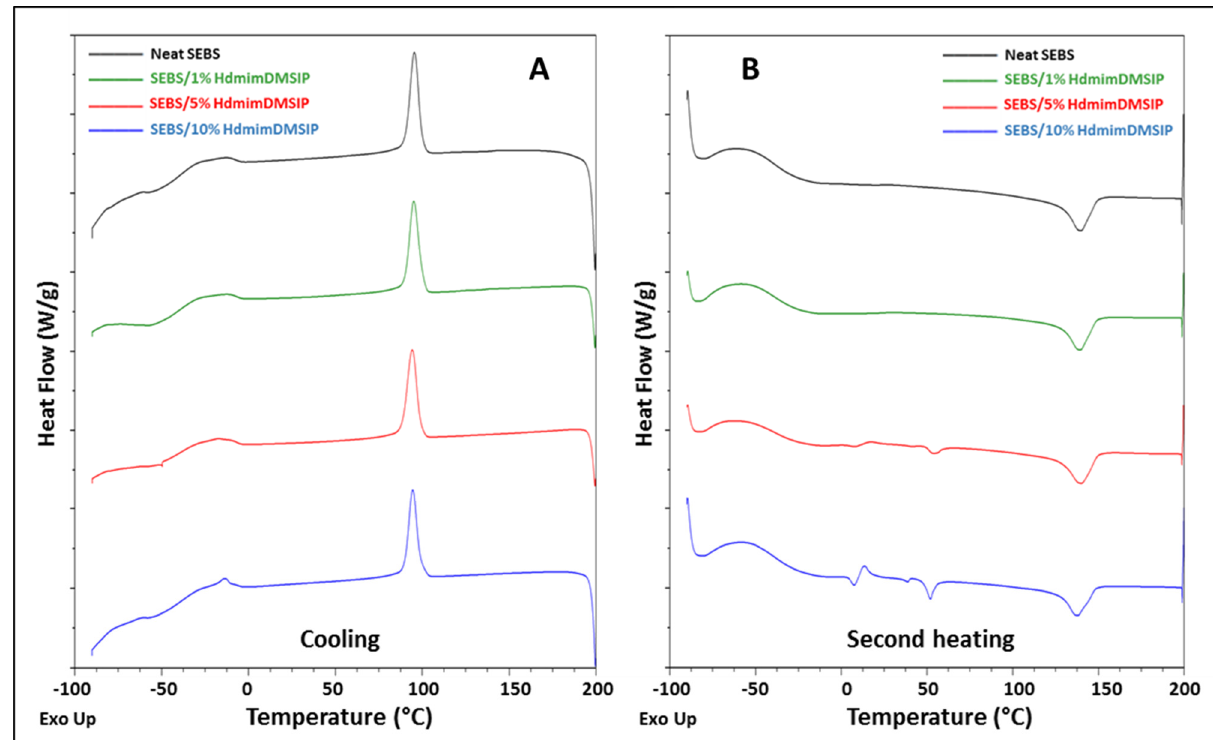
Figure 2. DSC curves of neat SEBS and SEBS/HdmimDMSIP blends during ( A ) the cooling and ( B ) the second heating runs. Curves are shifted for clarity.